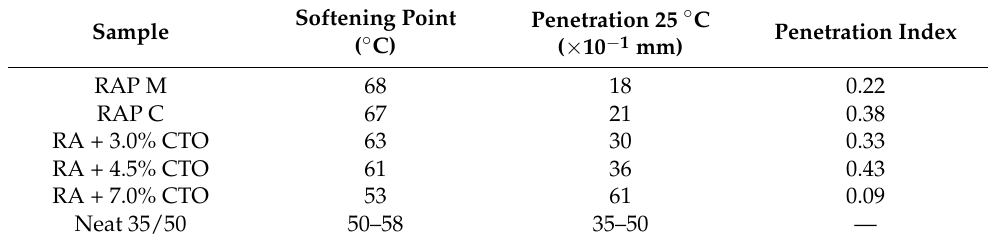
Table 2. Penetration, softening point and penetration index of RAP bitumen and rejuvenated